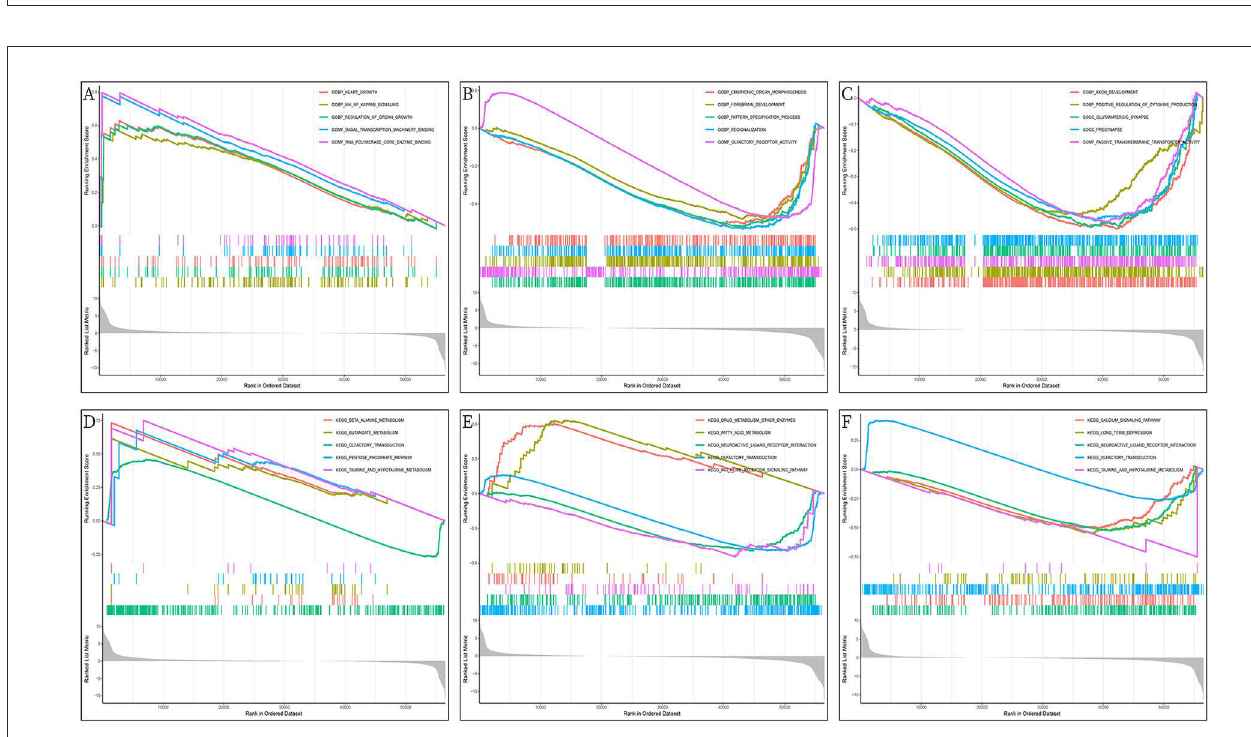
FIGURE12 GSEA enrichment analysis of DEGs ( PHGDH , NR1I2 , and APOC2 ); (A) GO enrichment analysis of PHGDH in HCC; (B) GO enrichment analysis of NR1I2 in HCC; (C) GO enrichment analysis of APOC2 in HCC; (D) KEGG enrichment analysis of PHGDH in HCC; (E) KEGG enrichment analysis of NR1I2 in HCC; (F) KEGG enrichment analysis of APOC2 in